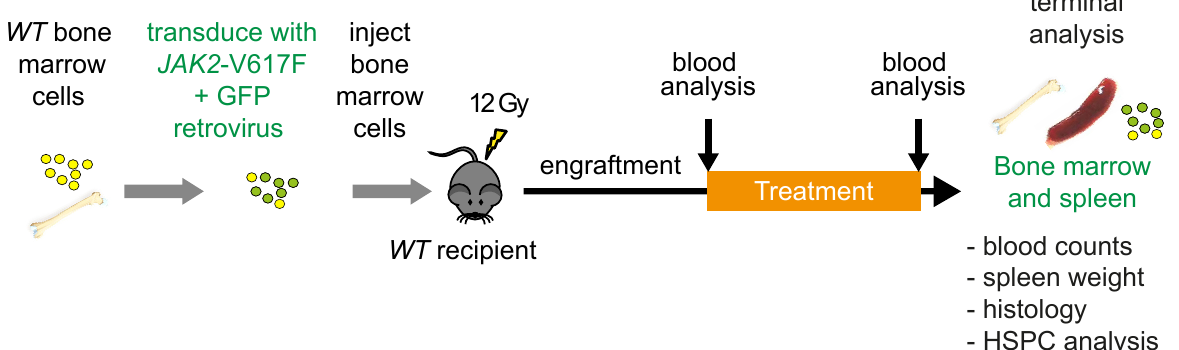
Fig. 1. Experimental setup for candidate drug testing in retroviral MPN mouse models. Wildtype ( WT ) bone marrow cells are transduced with murine retrovirus harboring the mutant JAK2 -V617F allele. Transduced bone marrow cells are selected based on expression of GFP reporter and transplanted via tail vein injection into the lethally irradiated syngeneic recipient mice. After engraftment, the recipient mice are allowed to develop MPN phenotype and are randomized into treatment or vehicle control groups. Complete blood counts and GFP chimerism are determined in peripheral blood at defined timepoints. At the end of the treatment the mice are sacrificed and terminal analysis of cells and organs is